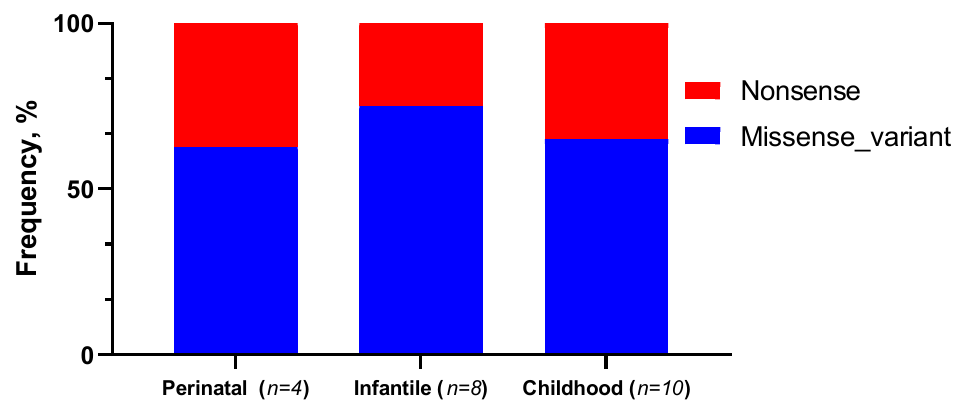
Figure 8. Frequencies of genetic variants in the ALPL gene depending on the HPP forms in the patients.